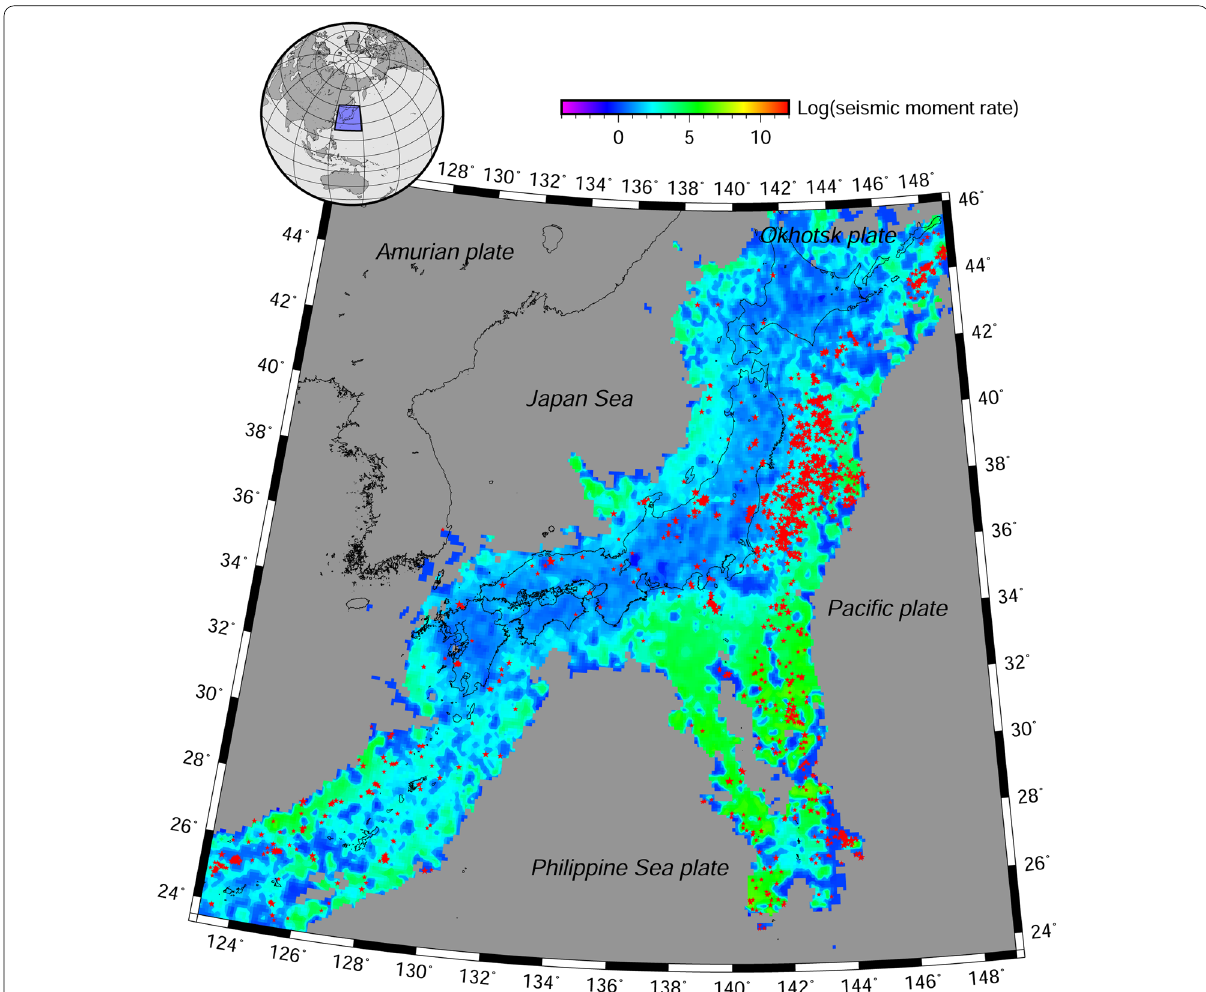
Fig. 10 Distribution of the seismic moment rate (log c ) value from 2009 to 2010 at a depth < 30 km using a threshold of 10,000 events for each seismically dense sphere compared to the epicenters of M5 earthquakes recorded. The color indicates the seismic moment rate from 2009 to + 2010 at a depth < 30 km. The red stars indicate the epicenters of M5 +